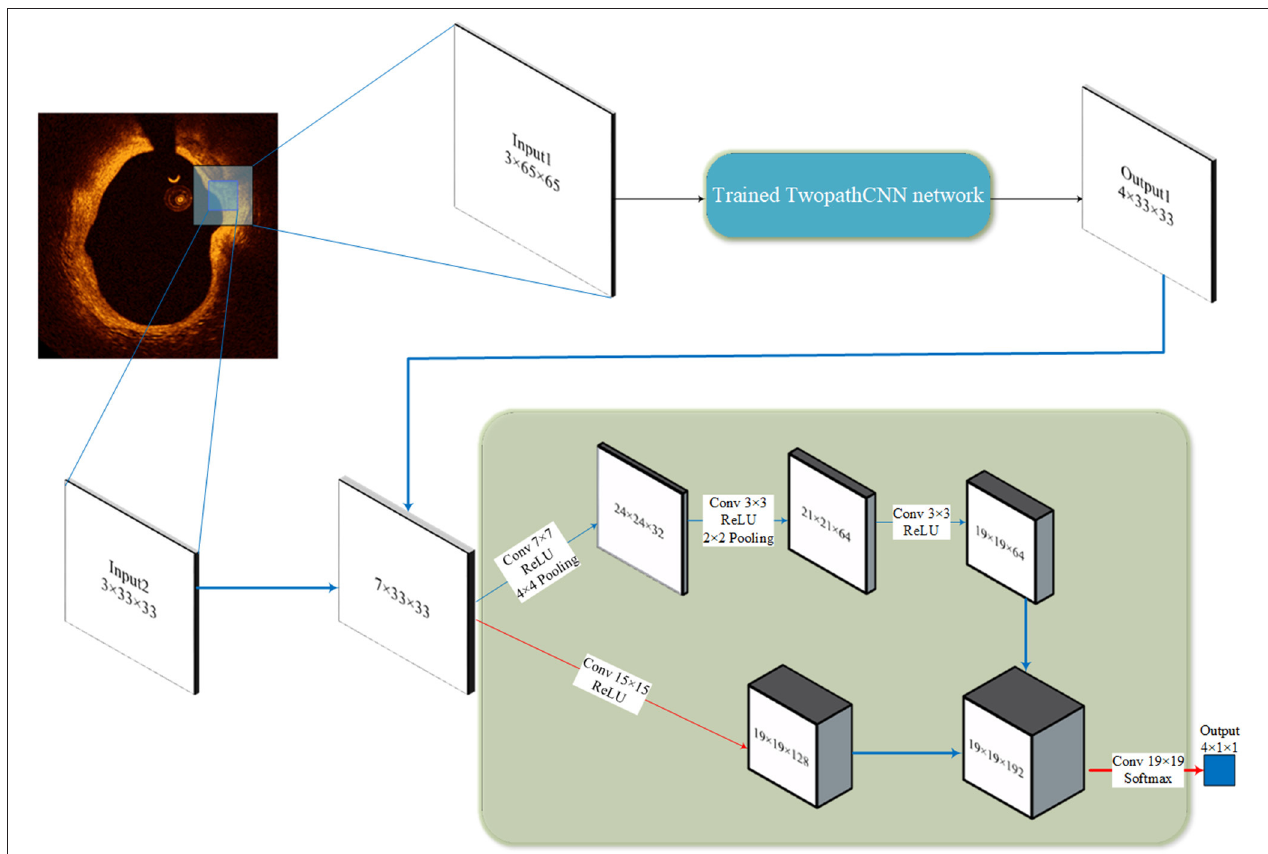
FIGURE 3 | Cascaded structure. The 65 33 33 patches to build new training ×